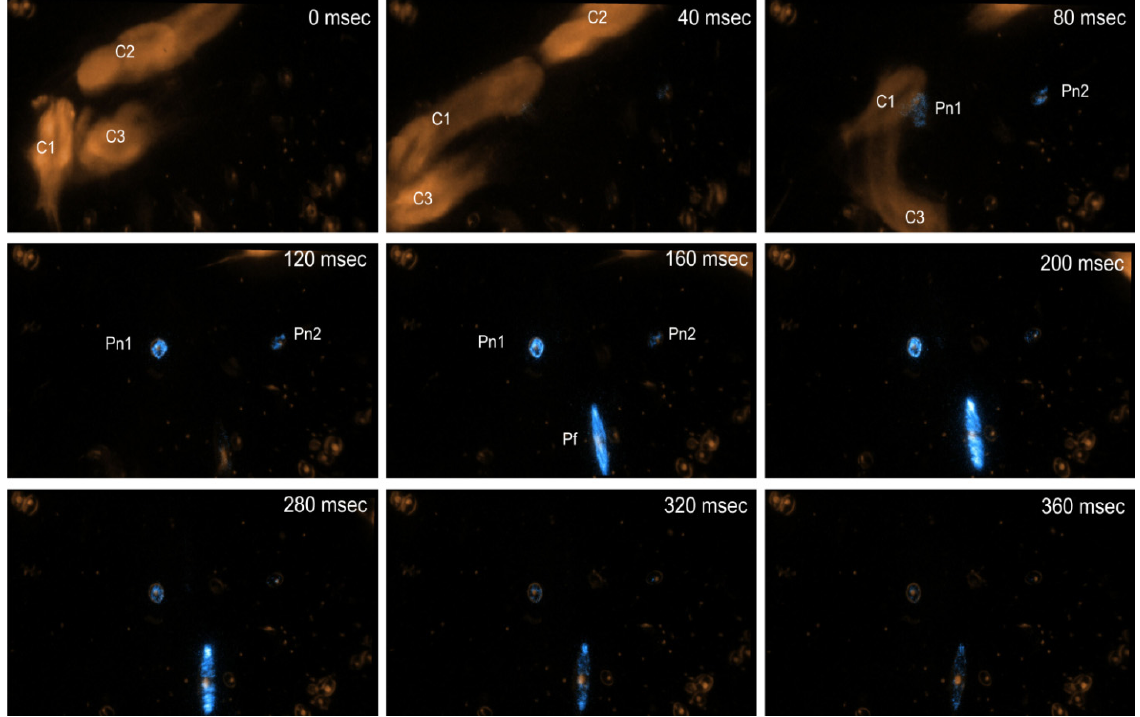
Figure 3. Image sequence from a video of bioluminescent dinoflagellates flashing in response to stimulation by copepods. The time from the beginning of the image sequence is indicated on each frame. Three copepods (C1–C3) collide and rapidly swim away from each other. During these fast swimming bursts, the dinoflagellates are stimulated to bioluminesce, although it is not possible to discern whether this is due to the copepod swimming current or to direct contact. Bioluminescence is seen to develop and diminish in the scintillons of two cells of Pyrocystis noctiluca (Pn) and a Pyrocystis fusiformis (Pf), which is pulled into the field of view at 160 ms by the copepod swimming current. The video was filmed by Ammonite Films at the National Oceanography Centre—Southampton. Filming was done under an inverted microscope at 10× magnification. The outline was captured using infrared light and bioluminescence was captured by a blue sensitive